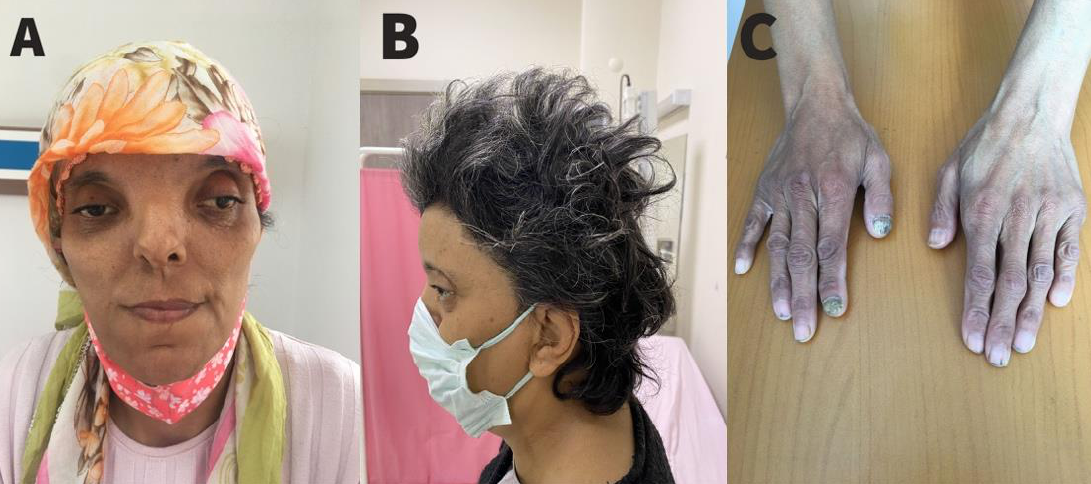
Figure 3. The abnormal appearance of the mother. ( A ) Syndromic facial appearance of the mother. ( B ) Brachycephaly and low-set ear. ( C ) Longitudinal bumps, splitting, and deformation on finger- nails.